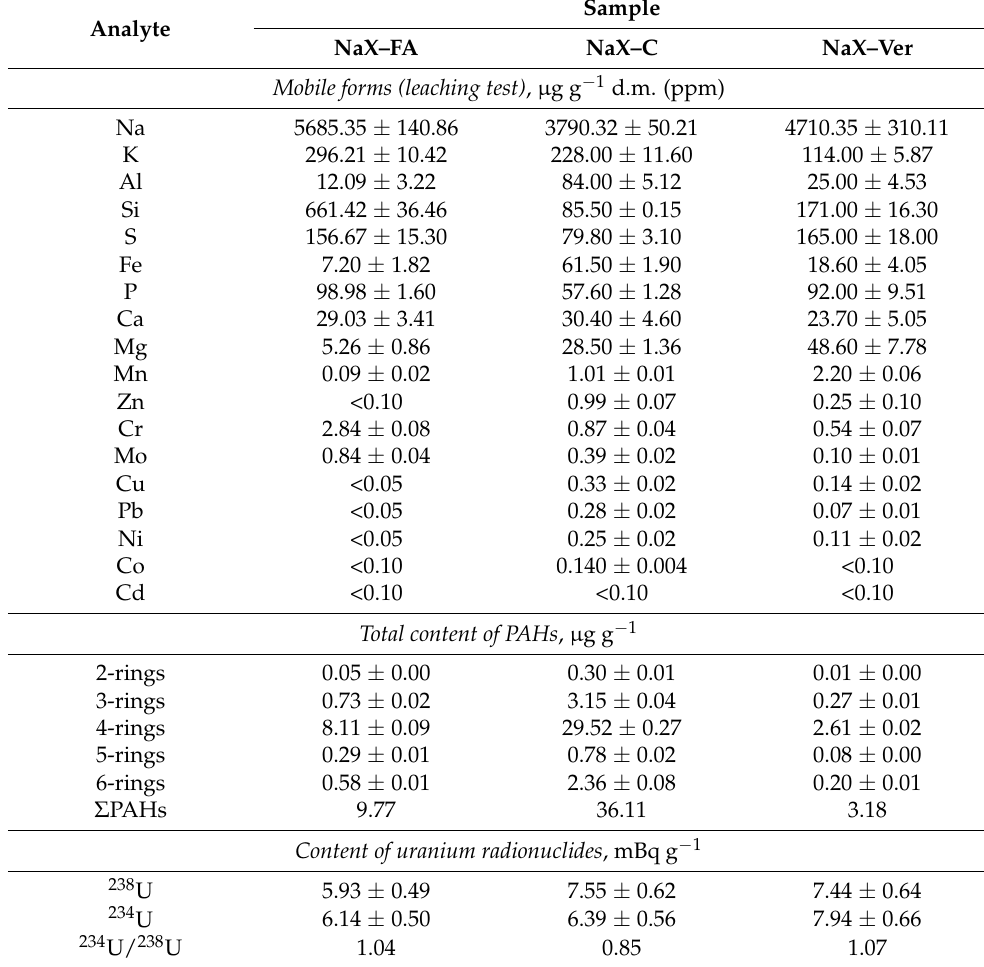
Table 3. Chemical characterization of investigated materials: leaching test, PAH contents, and uranium